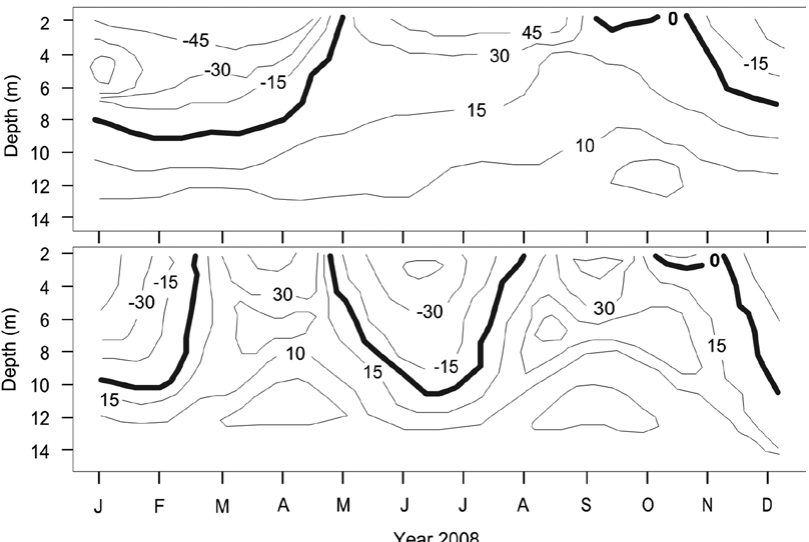
Fig. 7. – Residual contours of the a) u (east-west) and b) v (north-south) current velocities in cm s –1 from 6 January to 10 December 2008. In this case, the u component is perpendicular to the isobaths and the v component is parallel to the isobaths.